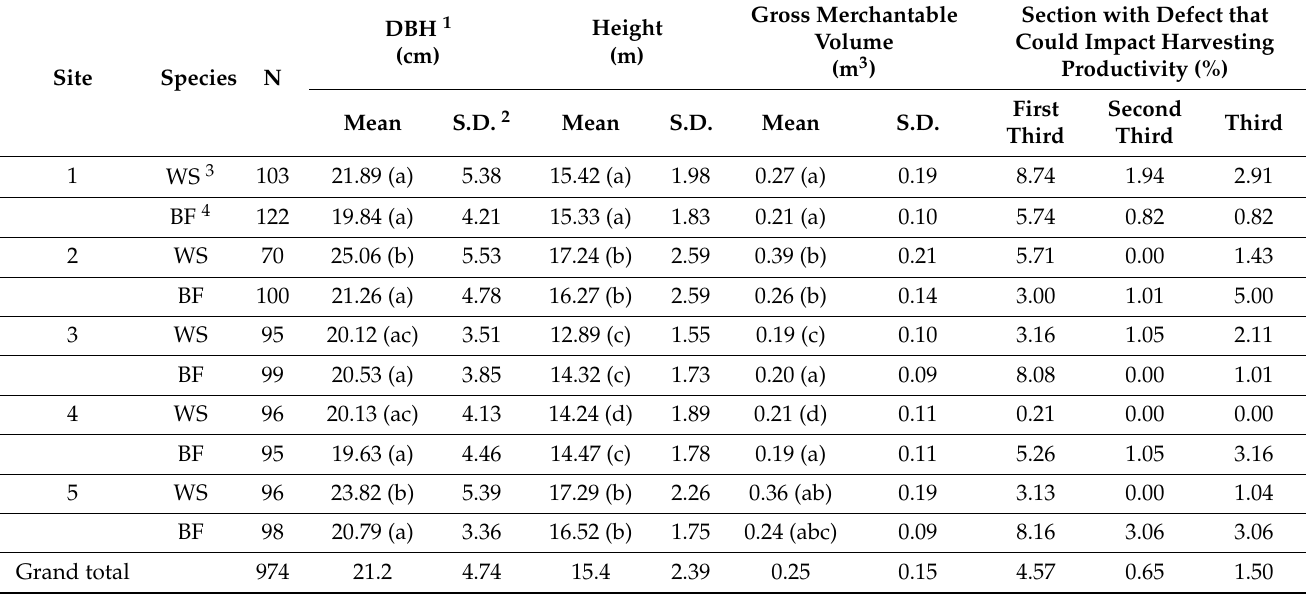
Table 3. Characteristics of study trees by study area. Statistical differences (aov function) based on Tukey test (Tukey HSD function) are illustrated in parentheses and are species dependent.